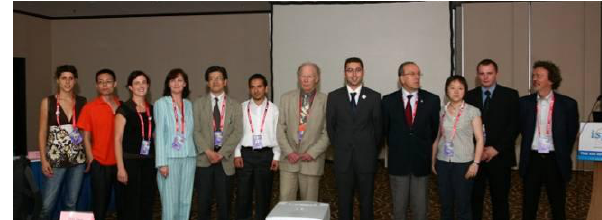
Figure 2. Group picture at the closing of the Youth Forum in Beijing 2008.